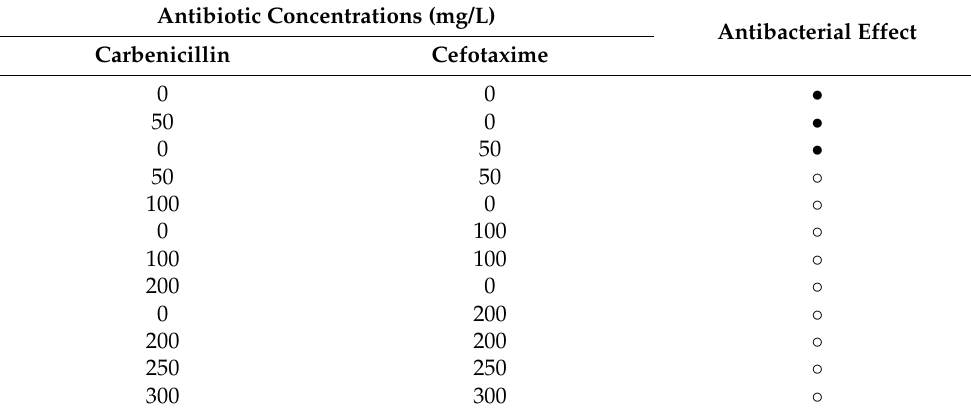
Table 1. Antibacterial antibiotic effect screening on